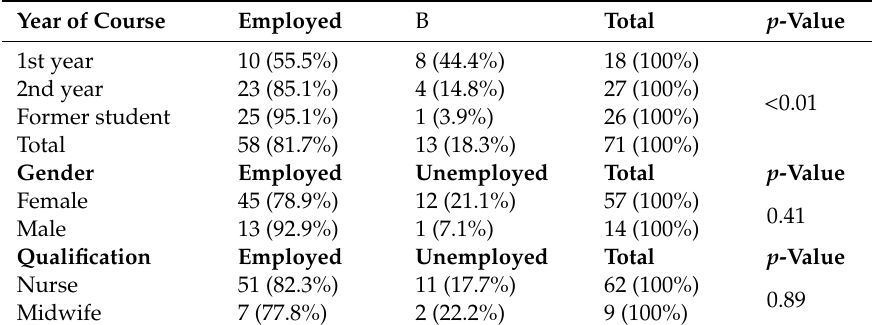
Table 2. Frequency distribution (values and row percentages) and p -value (Yates’s chi-squared test) of sample’s working situation, stratified by year of course, gender and professional qualification.